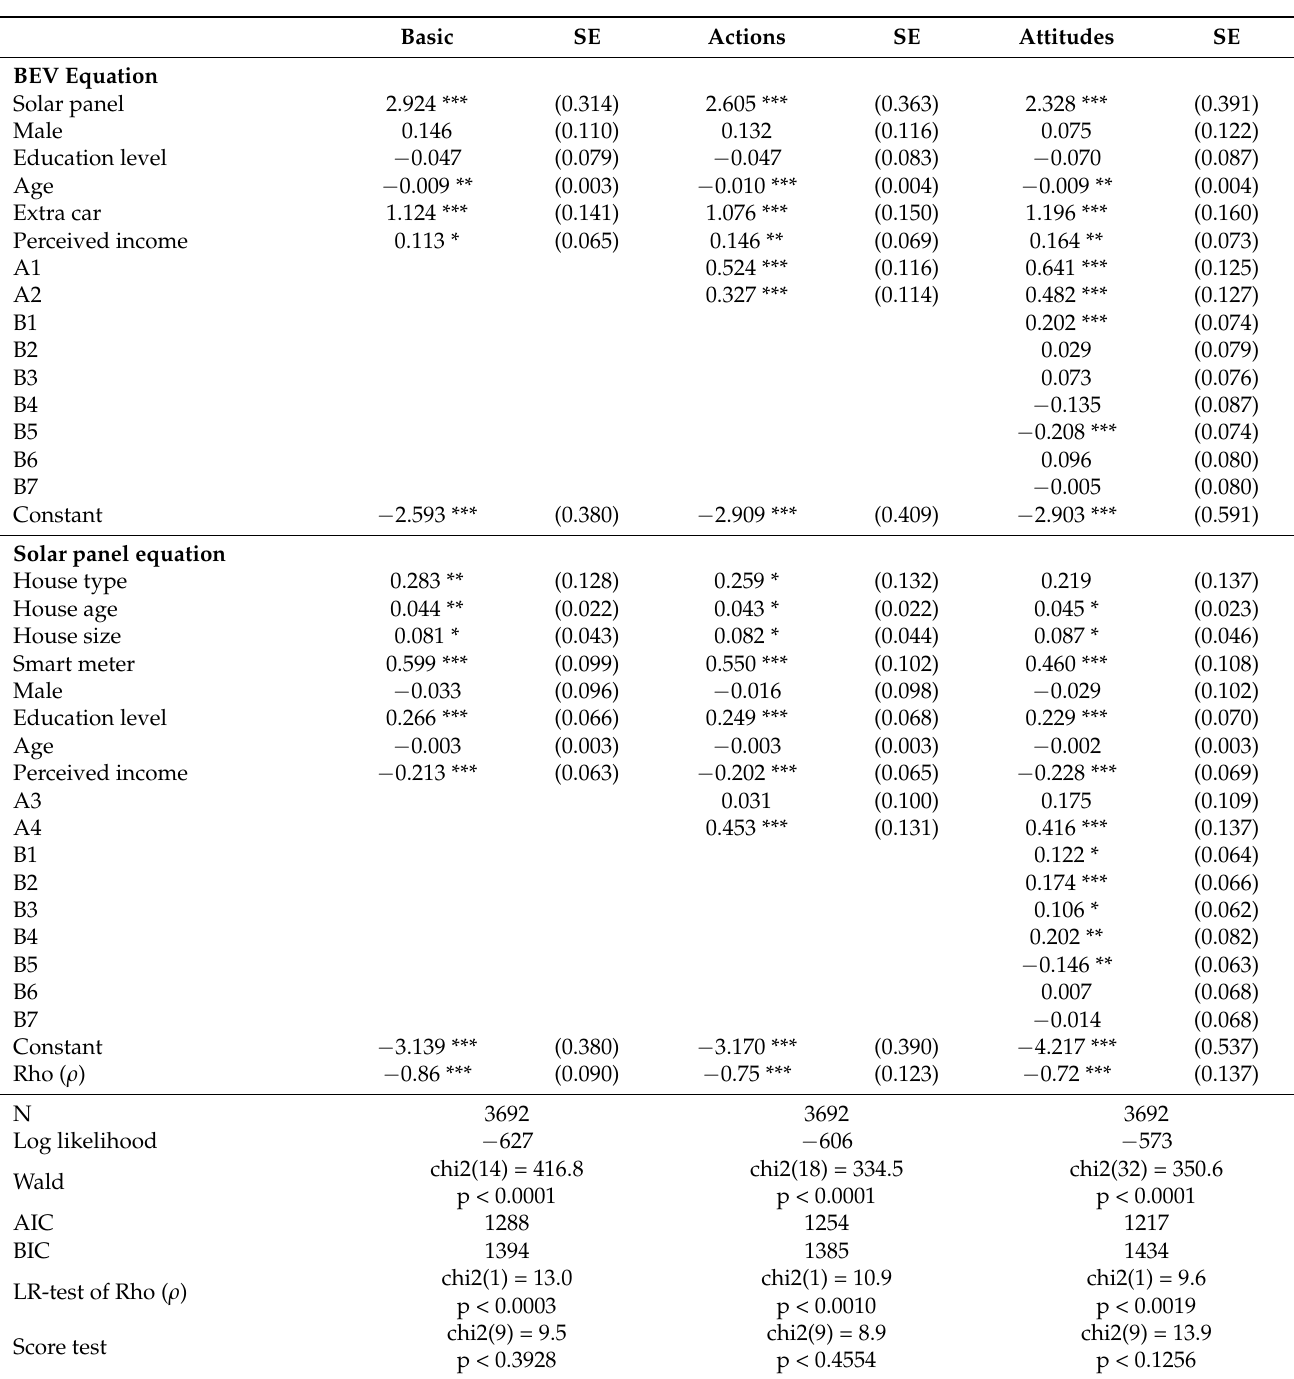
Table 3. Estimation results from the bivariate probit